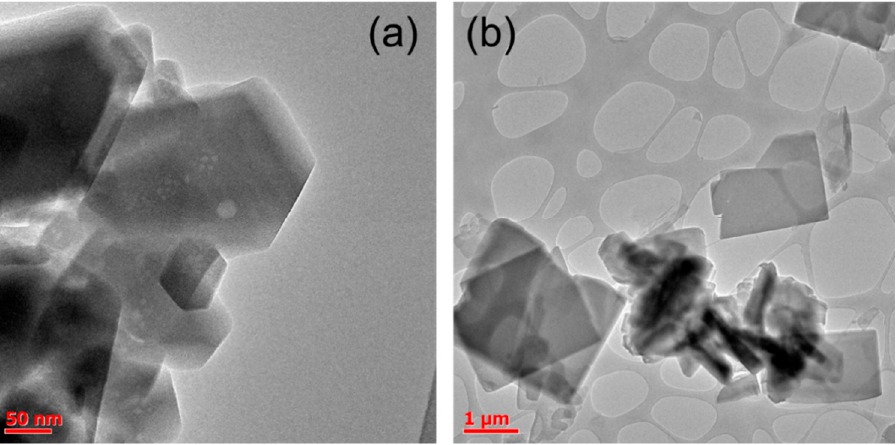
Figure 2. Transmission electron microscopy (TEM) images of synthesized samples ZIF-7 N,N-dimethylformamide (DMF) ( a ) and ZIF-7 N,N-diethylformamide (DEF) ( b ).